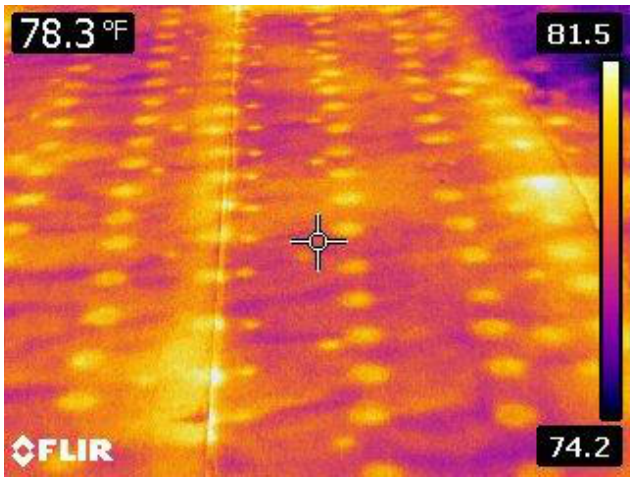
Figure 1. Infrared image of roofing, under cold conditions showing higher temperatures and thus greater heat loss at the location of metal fasteners.